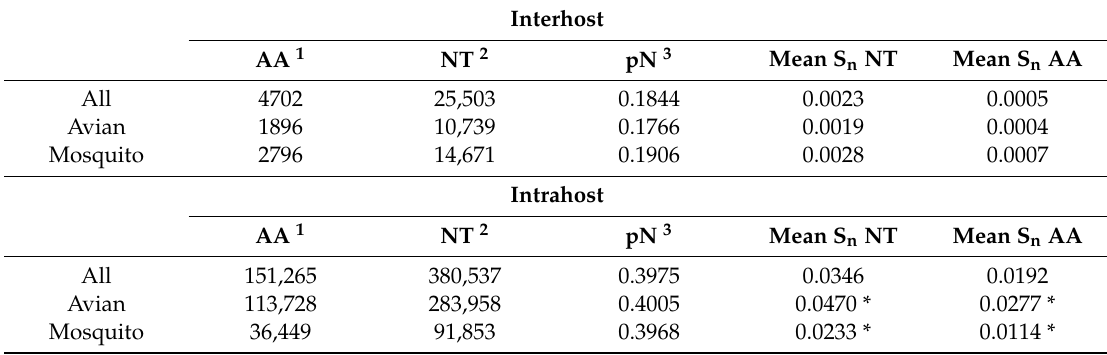
Table 1. Whole-genome average intra and interhost entropy (S n ) for each